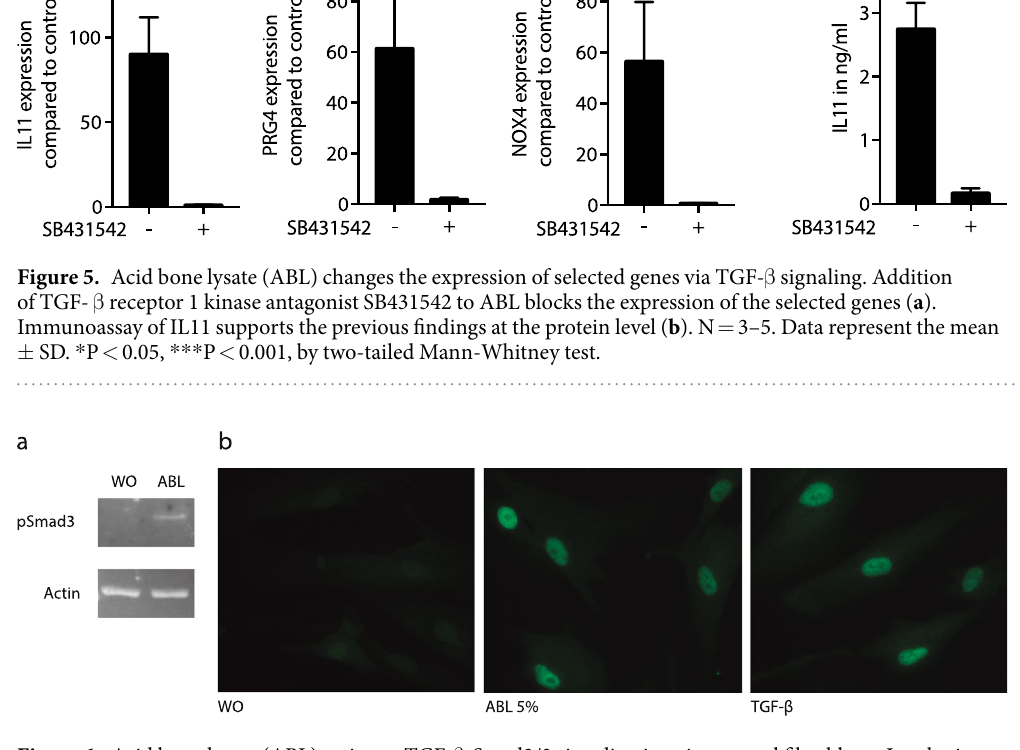
Figure 6. Acid bone lysate (ABL) activates TGF- β -Smad2/3 signaling in primary oral fibroblasts. Incubation of gingival fibroblasts with ABL also caused an increased phosphorylation of Smad3 ( a ). Representative immunofluorescence confirmed the translocation of Smad2/3 into the nucleus upon stimulation with ABL ( b ). Treatment with 10 ng/ml of TGF- β was used as a positive